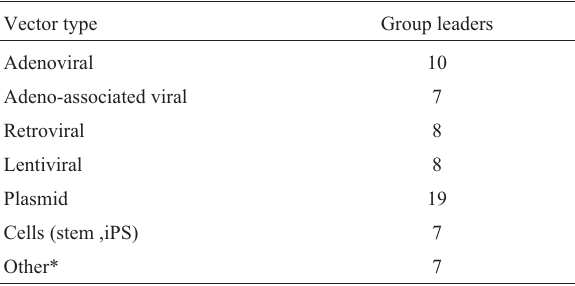
Table 2 - Gene transport vectors.